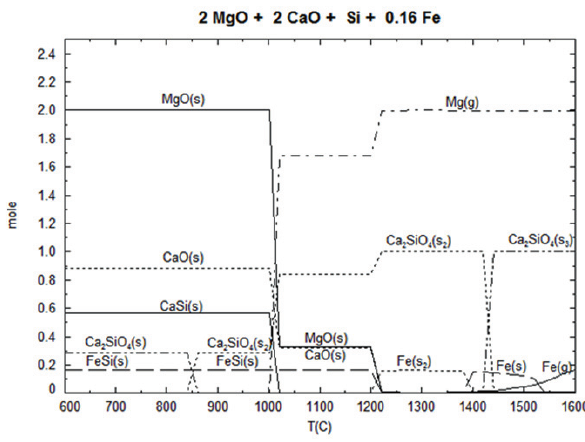
Figure 6. Simulation of Mg reduction considering the reac- tion 2MgO C Si C 0.16 Fe under 1 (cid:2) 10 2 Pa at different temperatures [14].